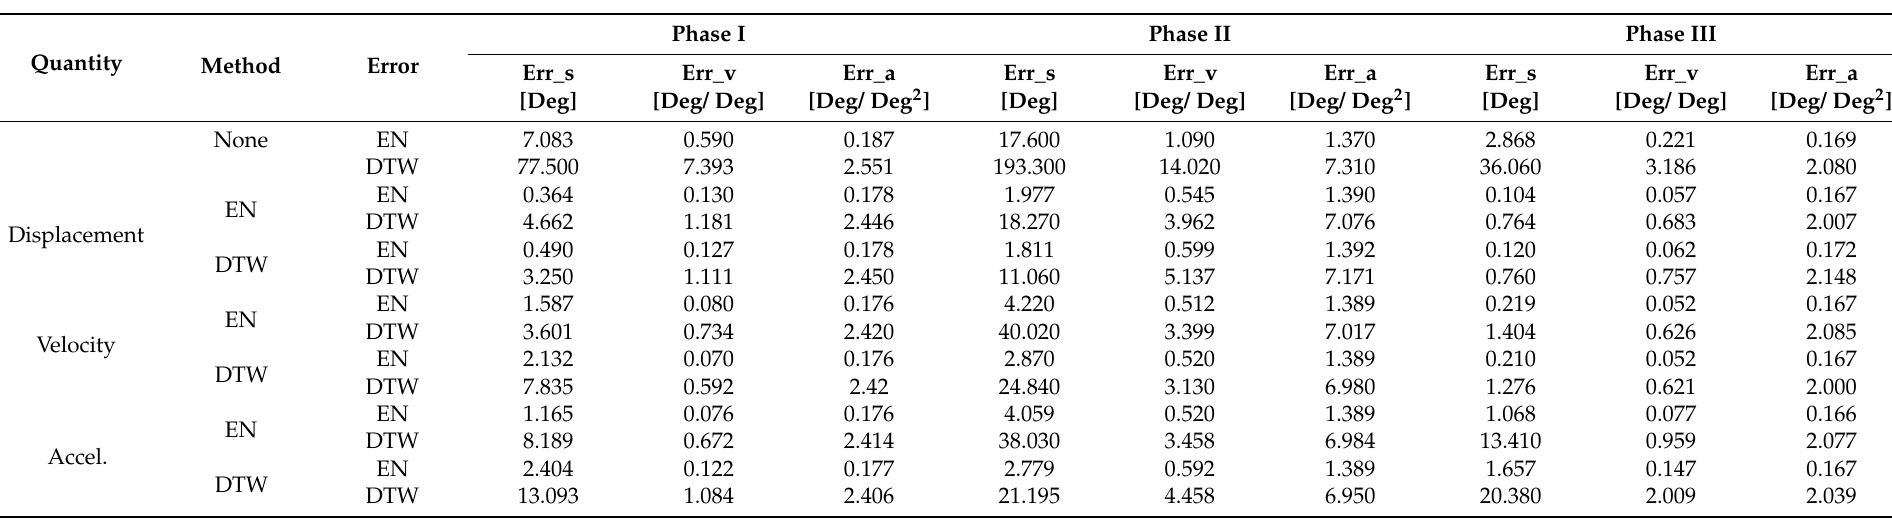
Table 9. Final values of the Euclidean norm and DTW algorithm on displacement, velocity and acceleration, in the actual cases after an identification based on